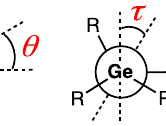
Figure 2. Second-order Jahn–Teller π – σ * orbital interaction accounting for the trans -bent distortion in the analogues of alkenes of the heavy group 14 elements.